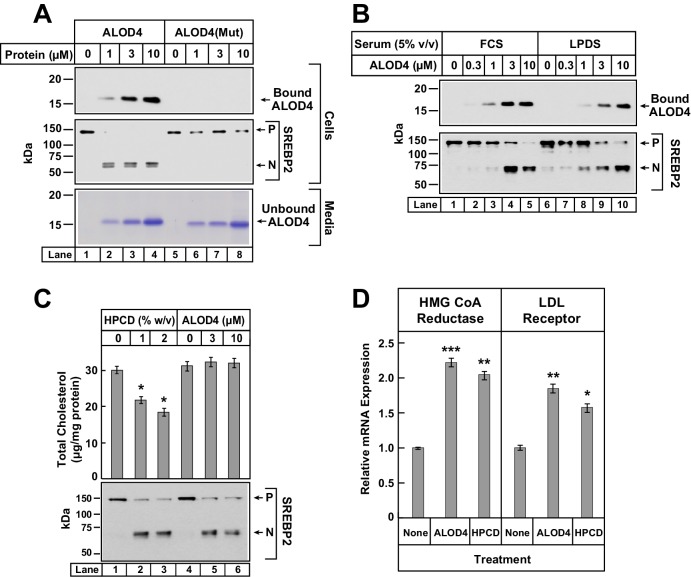
ALOD4 binding to cells activates SREBP2 transcription factors without changing cellular cholesterol levels.(A–B) Immunoblot analysis of CHO-K1 cells after incubation with ALOD4 or ALOD4(Mut) proteins in lipoprotein-rich or lipoprotein-poor serum. On day 0, CHO-K1 cells were set up in medium B at a density of either 3 × 104 cells/well of 48-well plates (A) or 6 × 104 cells/well of 48-well plates (B). On day 1 (B) or day 2 (A), media was removed, cells were washed with 500 µl of PBS and then the following additions were made: 200 µl of medium C with indicated concentrations of ALOD4 or ALOD4(Mut) (A) or 200 µl of lipoprotein-rich medium C or lipoprotein-poor medium F with indicated concentrations of ALOD4 (B). After incubation for 1 hr at 37°C, media was collected, and cells were harvested as described in Materials and methods. Equal aliquots of cells and media (10% of total) were subjected to immunoblot analysis or Coomassie staining as described in Materials and methods. (C) Cellular cholesterol levels decline after treatment with HPCD, but not after treatment with ALOD4. On day 0, CHO-K1 cells were set up in medium B at a density of 2.5 × 105 cells/60 mm dish. On day 3, media was removed, followed by addition of 200 µl of medium C with the indicated concentration of HPCD or ALOD4. After incubation for 1 hr at 37°C, media was removed and cells were harvested as described in Materials and methods. An aliquot of cells (5% of total) was used for immunoblot analysis (25 µg/lane), and the remainder was used for quantification of cholesterol as described in Materials and methods. Each column represents the mean of cholesterol measurements from three independent experiments, and error bars show the standard error (top panel). Asterisks denote level of statistical significance (Student t test) between cells treated without and with HPCD: *p<0.05. Immunoblot analysis of the cells from one of the three experiments is shown in the bottom panel. (D) ALOD4 treatment causes increases in mRNA levels of HMG CoA Reductase and LDL receptor genes. On day 0, CHO-K1 cells were set up in medium B at a density of 5 × 105 cells/100 mm dish. On day 2, media was removed, followed by addition of 2 ml of medium C in the absence or presence of ALOD4 (5 µM) or HPCD (1% w/v). After incubation for 4 hr at 37°C, media was removed, and cells were harvested for measurement of the indicated mRNA by quantitative RT-PCR as described in Materials and methods. For each gene, the amount of mRNA from untreated cells is set to 1, and mRNA amounts from cells treated with ALOD4 or HPCD are expressed relative to this reference value. Each column represents the mean of relative mRNA values measured in three independent experiments, and error bars show the standard error. Asterisks denote level of statistical significance (Student t test) between cells treated without and with ALOD4 or HPCD: *p<0.05; **p<0.01; ***p<0.001. The average Ct values for actin (invariant control) were 15.38, 15.31, and 15.18 for the untreated, ALOD4-treated, and HPCD-treated conditions, respectively. The average Ct values for HMG CoA Reductase and LDL receptor were 21.3 and 22.3, respectively, for the untreated condition. P = precursor form of SREBP2; N = cleaved nuclear form of SREBP2.